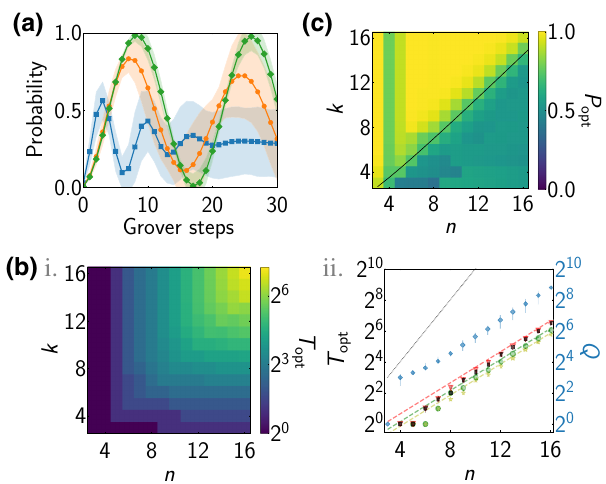
FIG. 3. Number partitioning with generalized oracle of step width γ = 2 − k . (a) Success probability P T for n = 8, k = 4, 8, 12 (blue squares, orange circles, and green diamonds). Shading indi- cates standard deviation over 5000 instances of the weights. (b.i) Optimal number of iterations T opt versus ( n , k ) . (b.ii) T opt for n = k , grouped by number of solutions N A = 2, 4, 6 (red triangles, green circles, and yellow stars) and compared with √ asymptotic theory T opt ∝ N (dashed lines). Black squares show average over all instances. Dotted gray line indicates linear scal- for ing T opt ∝ N . Blue diamonds show median speedup [ Q ] 0.5 n = k , with error bars indicating interquartile range. (c) Prob- ability P opt versus ( n , k ) . Black line shows critical bit depth k c ( n )